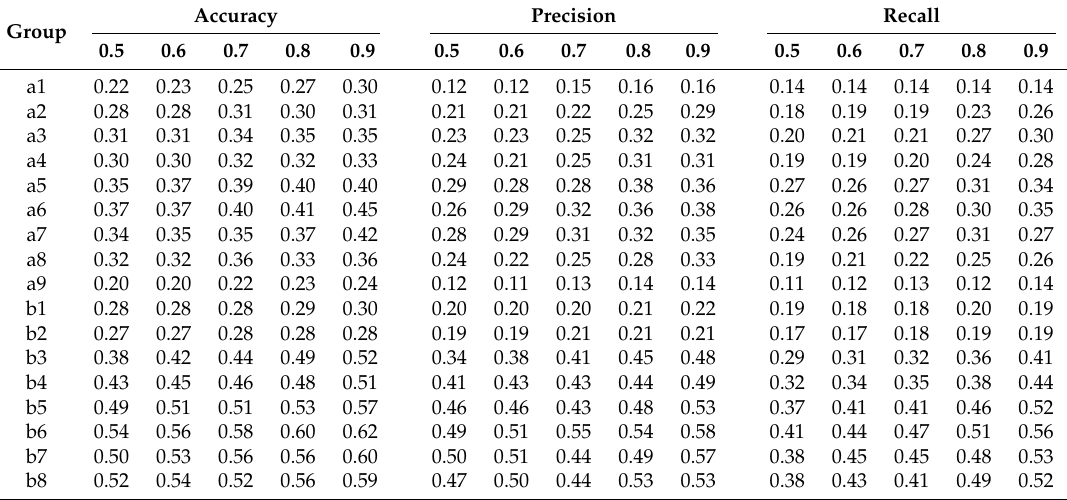
Table 3. Average performance of unimodal data based experimental